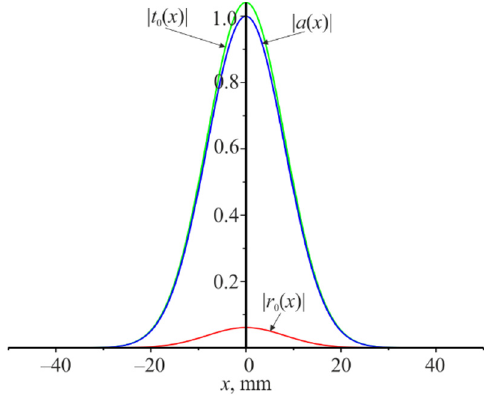
Figure 6. Amplitudes modules distribution of | a ( x ) | (blue), | r 0 ( x ) | (red), and | t 0 ( x ) | (green) along the x coordinate. The wavelength is 1000 nm, the width of the Gaussian beam incident on the grating is 𝐿 = 20 mm .